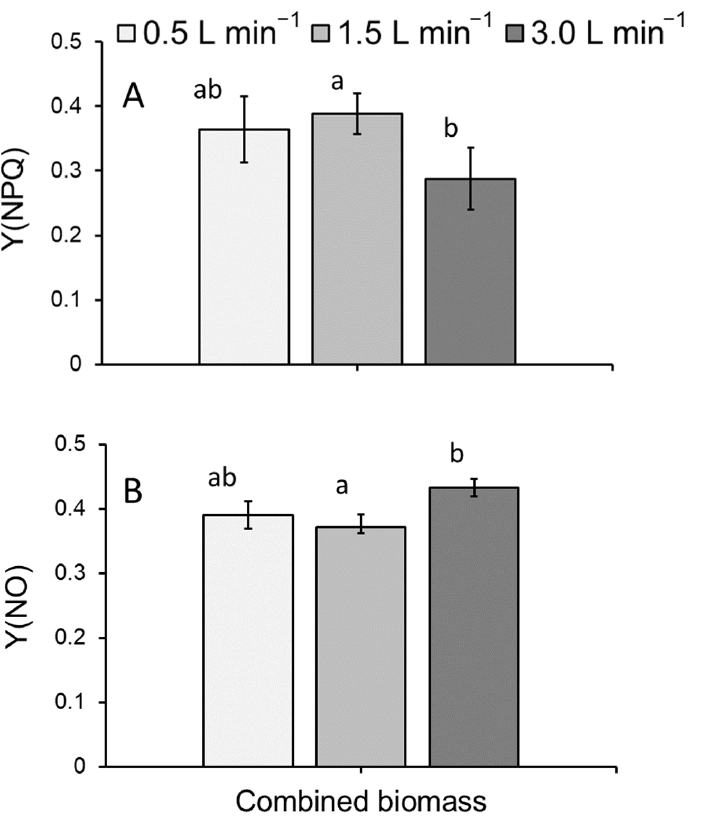
Figure 5. Mean (±SE) ( A ) Y(NPQ) and ( B ) Y(NO), for Lemna minor grown within an indoor, vertically stacked system. As no effect of depth or tray was detected, medium depths and tray positions have been pooled in this simplified model depiction. Letters show statistical similarity ( p > 0.05).